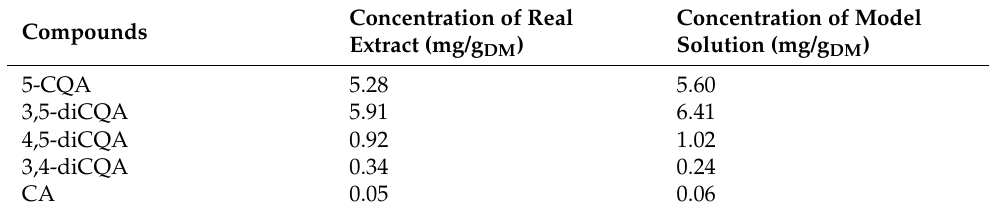
Table 9. Composition of the multi element model solution and real extract. Concentration of Real Concentration of Model Compounds Extract (mg/g DM ) Solution (mg/g DM ) 5-CQA 5.28 5.60 3,5-diCQA 5.91 6.41 4,5-diCQA 0.92 1.02 3,4-diCQA 0.34 0.24